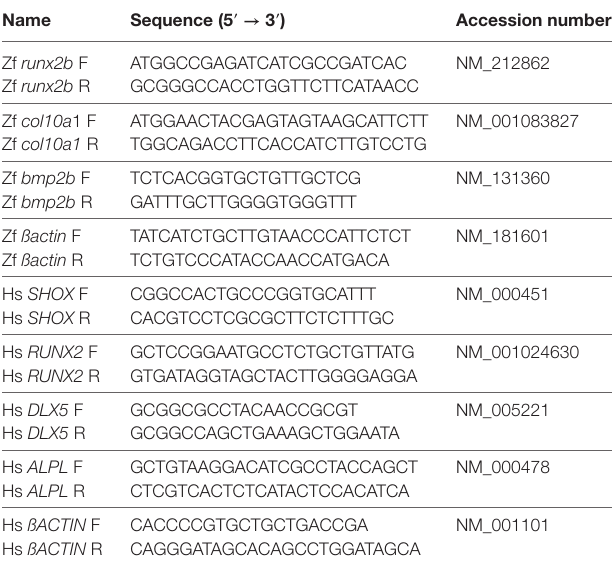
TaBle 1 | List of primer sequences used in quantitative